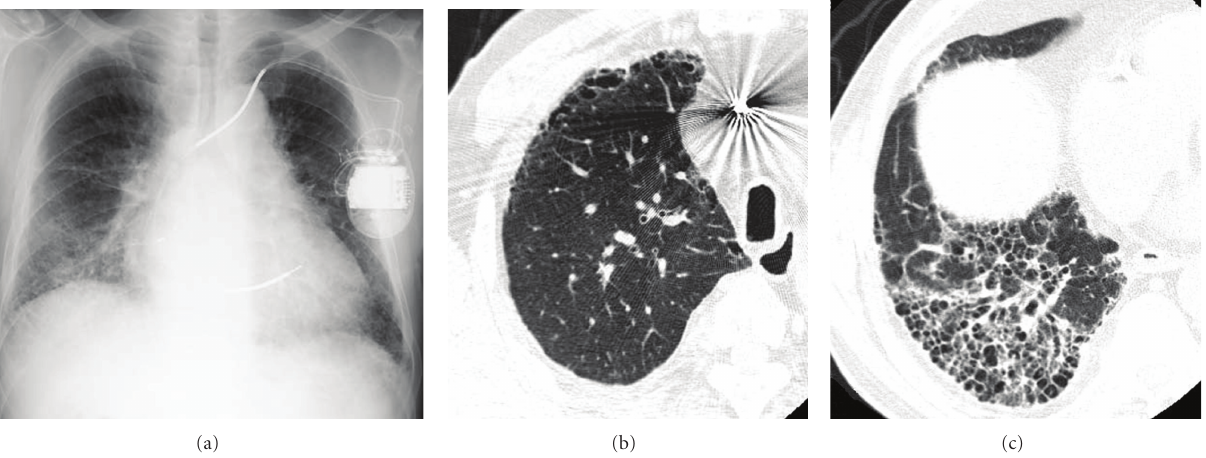
Figure 2: Di ff use interstitial pneumonia (UIP pattern) with emphysema. (a) Chest X-ray shows decreased volume of bilateral lungs. Ground glass opacity including reticular opacity and honeycomb lung in bilateral lower lungs. (b) HRCT of the right upper lobe shows paraseptal emphysema in ventral aspect. (c) HRCT of the right lower lobe shows ground glass opacity and honeycomb lung. Traction bronchiectasis is also observed within the areas of